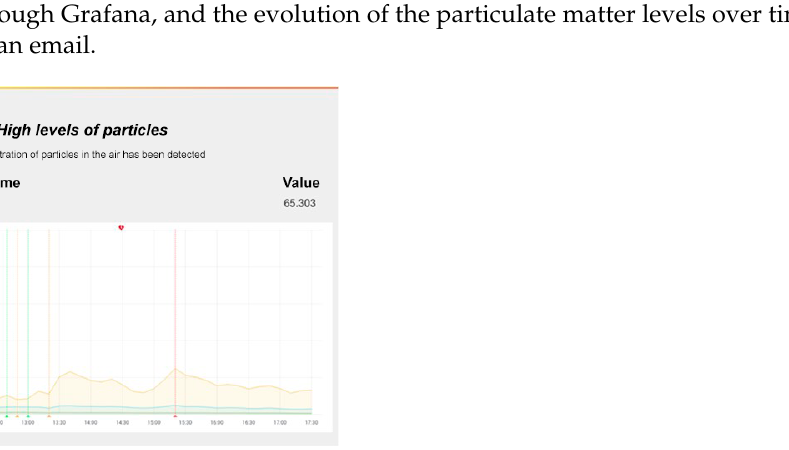
Figure 11. Alert for high PM10 particulate matter levels in the air using the service integrated in